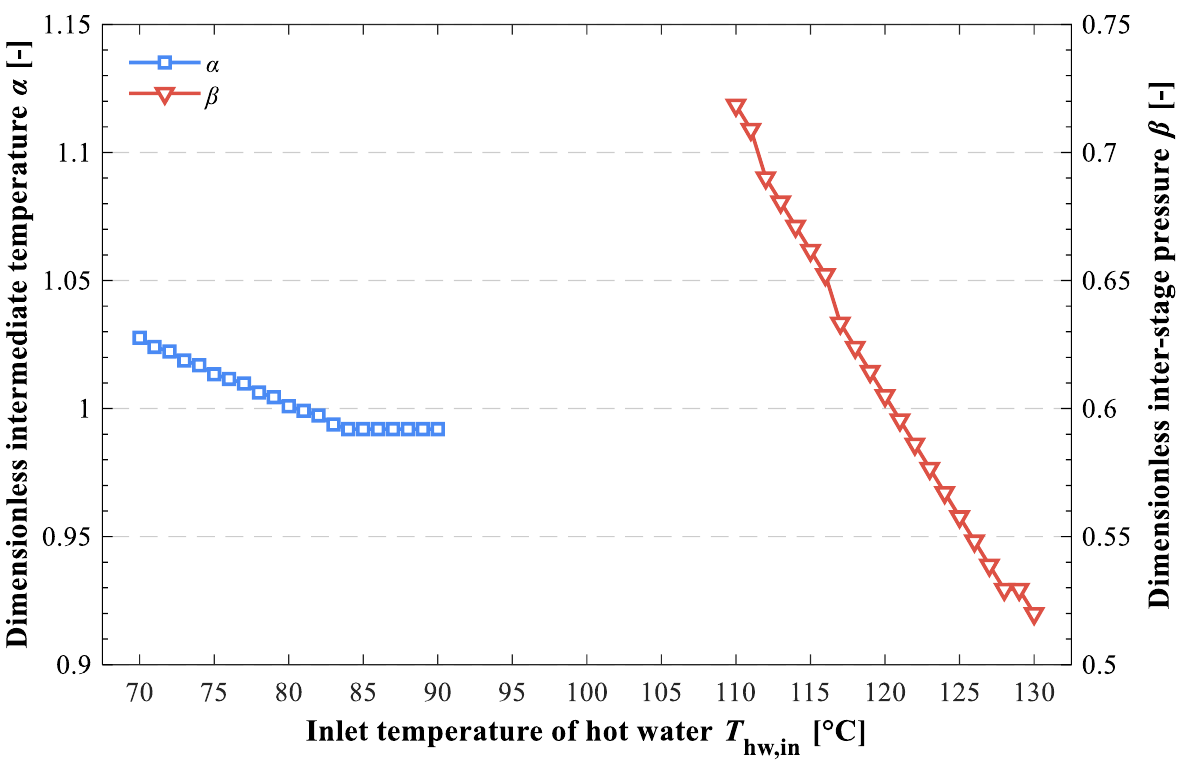
Figure 13. Effect of inlet temperature of hot water on dimensionless optimum intermediate temperature and inter-stage pressure.